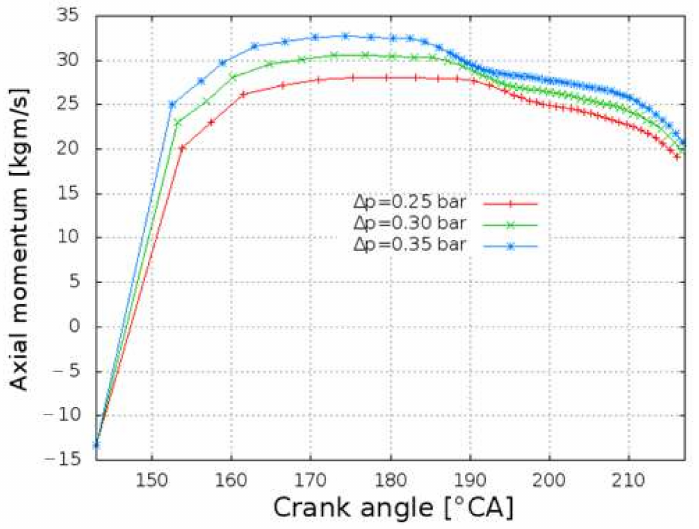
Figure 12. The variation of axial momentum over time for different pressure differences.